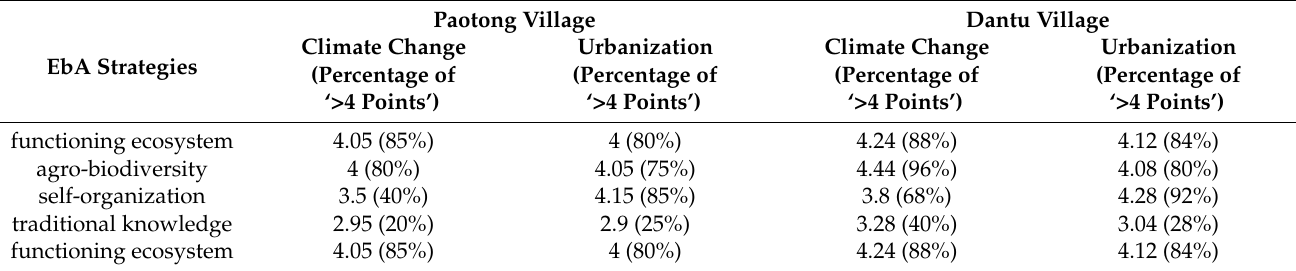
Table 5. Farmers’ perception of the importance of EbA